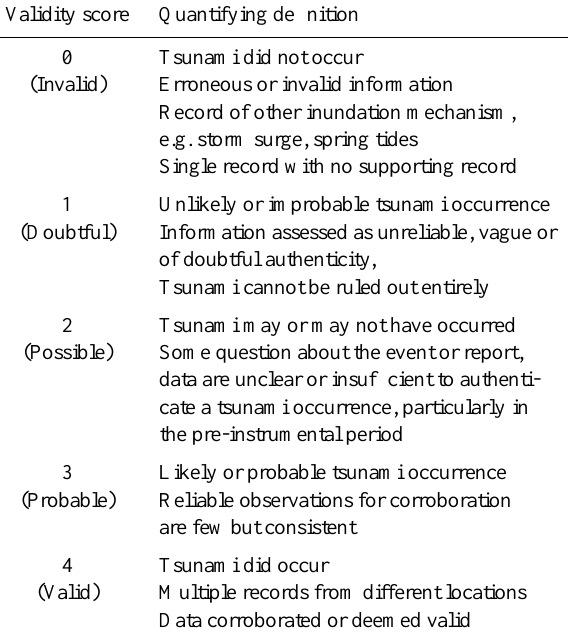
Table 4. Values quantifying historical tsunami validity rating pa- rameters in Caribbean Tsunami History (after O’Loughlin and Lan- der, 2003, p. 25).